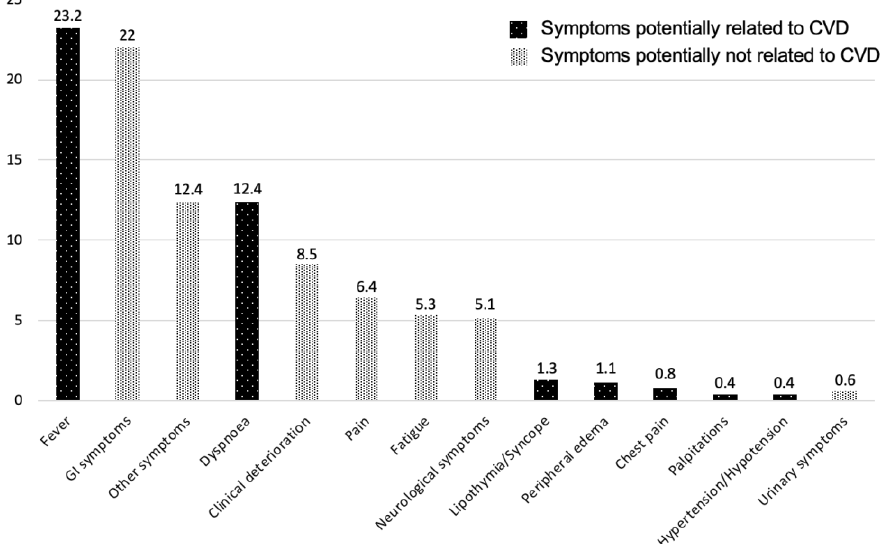
Figure 2. Distribution of presenting symptoms in the emergency department. CVD, cardiovascular disease; GI, gastrointestinal.